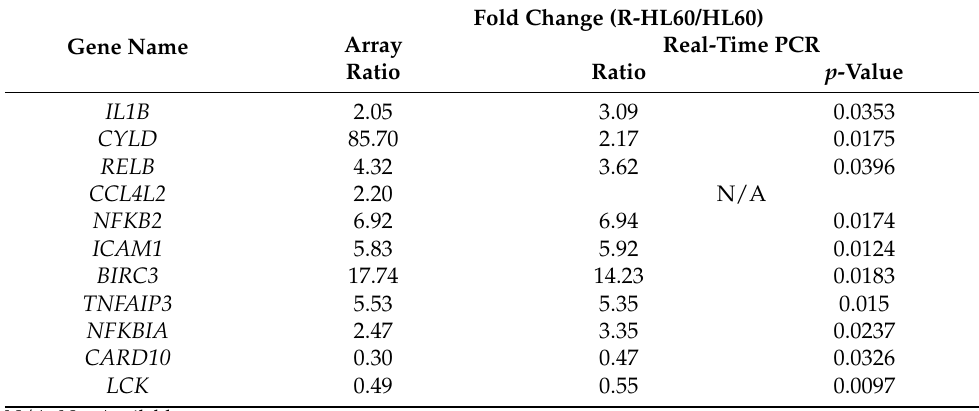
Table 2. Gene expression differences determined using gene expression array and real-time